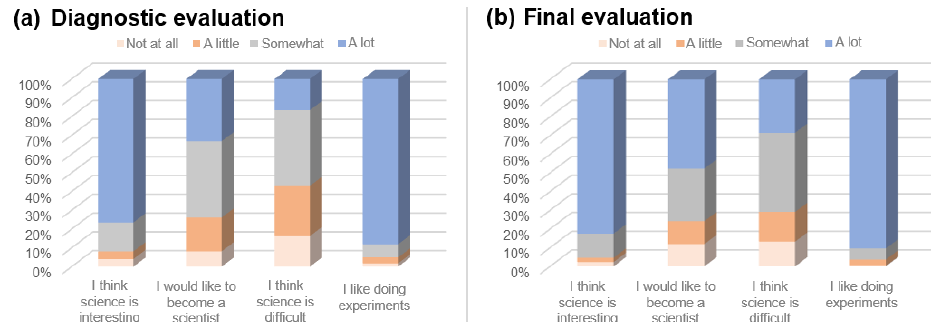
Figure 11. Compilation of answers to questions related to perceptions of science and scientists before (a) and after (b) the